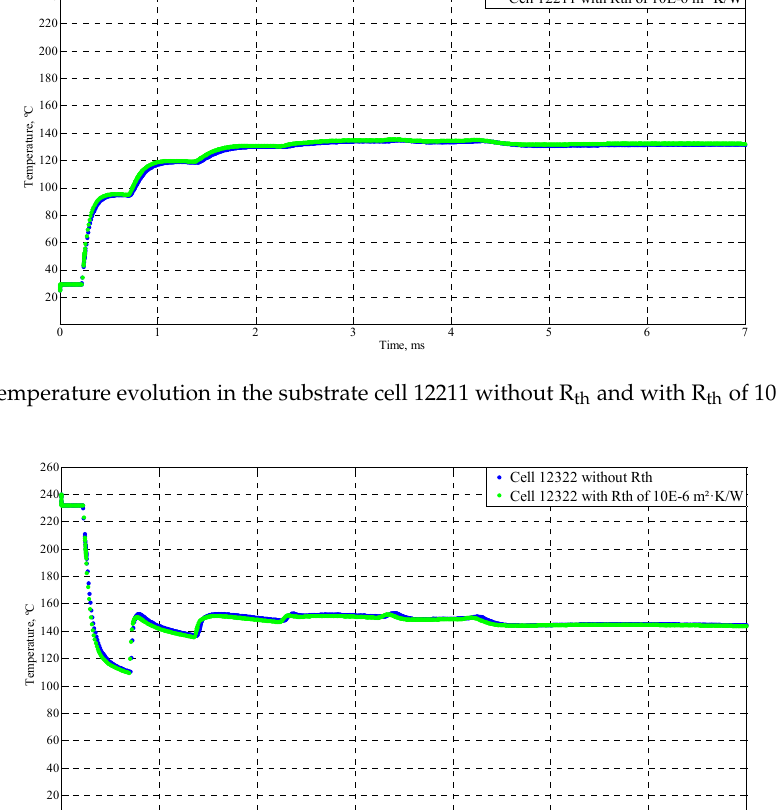
Figure 8. Comparison between experimental and simulated data for the steel temperature at the tin drop center. 4.2. Simulation of Alumina Splats Solidification without Preheating Substrate After verifying the network model with a tin splat, we are able to calculate the solidification of an alumina splat at 2070 °C on a steel substrate at 25 °C, i.e., without preheating. In order to know the average diameter of pancake splats, several tests using a mask with holes with a diameter of 1 mm and proper spraying parameters provides a set of this kind of splat. The material used was a powder with a size of − 20 + 5 μ m and the resulting average particle diameter was 17.7 μ m; and after the spraying process the average splat diameter calculated from samples set was 30 μ m analysed by a scanning electron microscope (SEM). In this case the thickness can be obtained by: 𝑒 = 4 3 · (cid:3435)d (cid:2926) /2(cid:3439) (cid:2871) (cid:4666)D/2(cid:4667) (cid:2870)